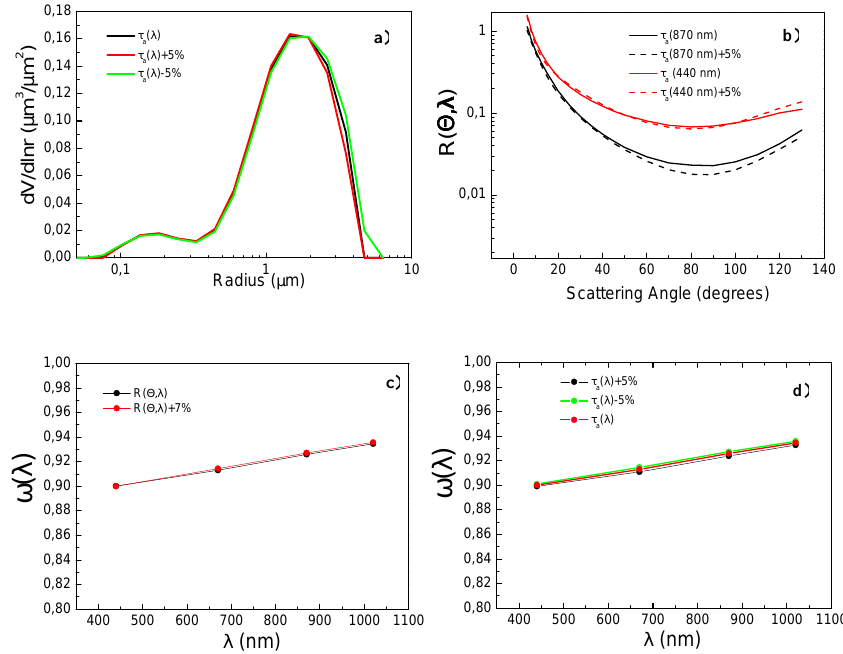
Fig. A3. Retrieval results with and without errors in input data for the Saharan dust case detected over Granada on 23 June 2008. (a) Volume size distribution retrievals derived using as input parameters τ a (λ) , τ a (λ) − 5% and τ a (λ) +5%; (b) R( 2 , λ) retrievals derived using as input parameters τ a (λ) , τ a (λ) − 5% and τ a (λ) +5%; (c) ω ( λ) retrievals derived using as input parameters R( 2 , λ) and R( 2 , λ) +7%, and (d) ω ( λ) retrievals derived using as input parameter τ a (λ) , τ a (λ) -5% and τ a (λ) + 5%.